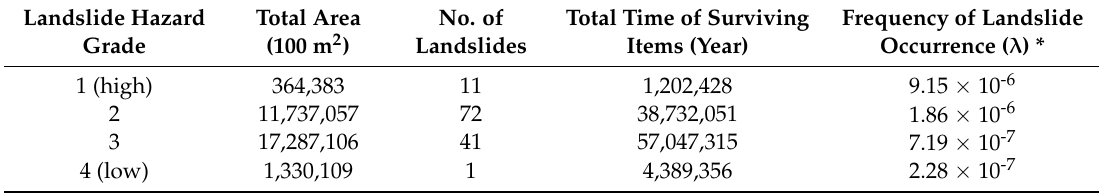
Table 5. Frequency estimation of landslide occurrence based on the probabilistic return period.